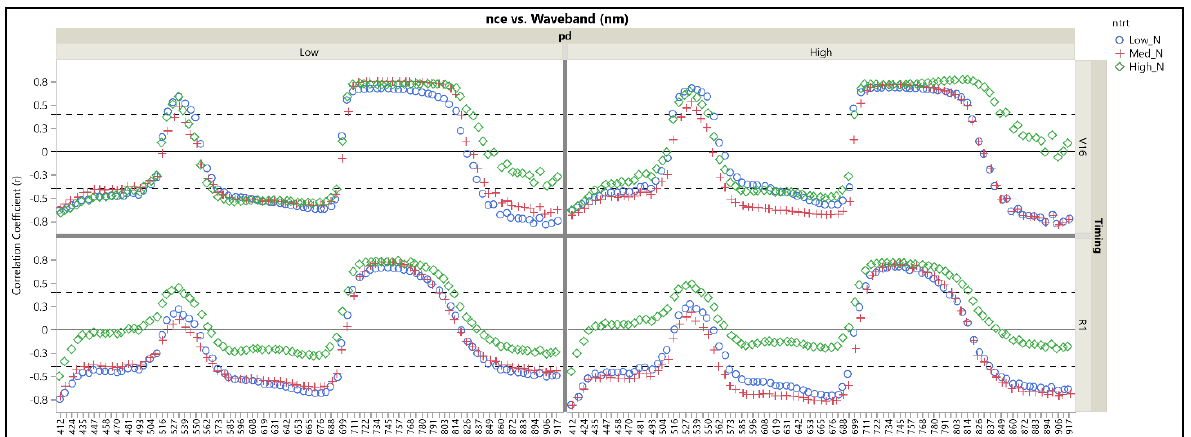
Figure 3. Pearson product-moment correlations (r) for NCE at R6 (kg/kg N) by waveband (nm) from images at V16 (upper block) or R1 (lower block) for low and high planting density (pd) colored shape by N treatment (Low N = blue circle, Med N = red plus, High N = green diamond). Black lines are for reference only: solid line is at r = 0 and dashed lines at r =